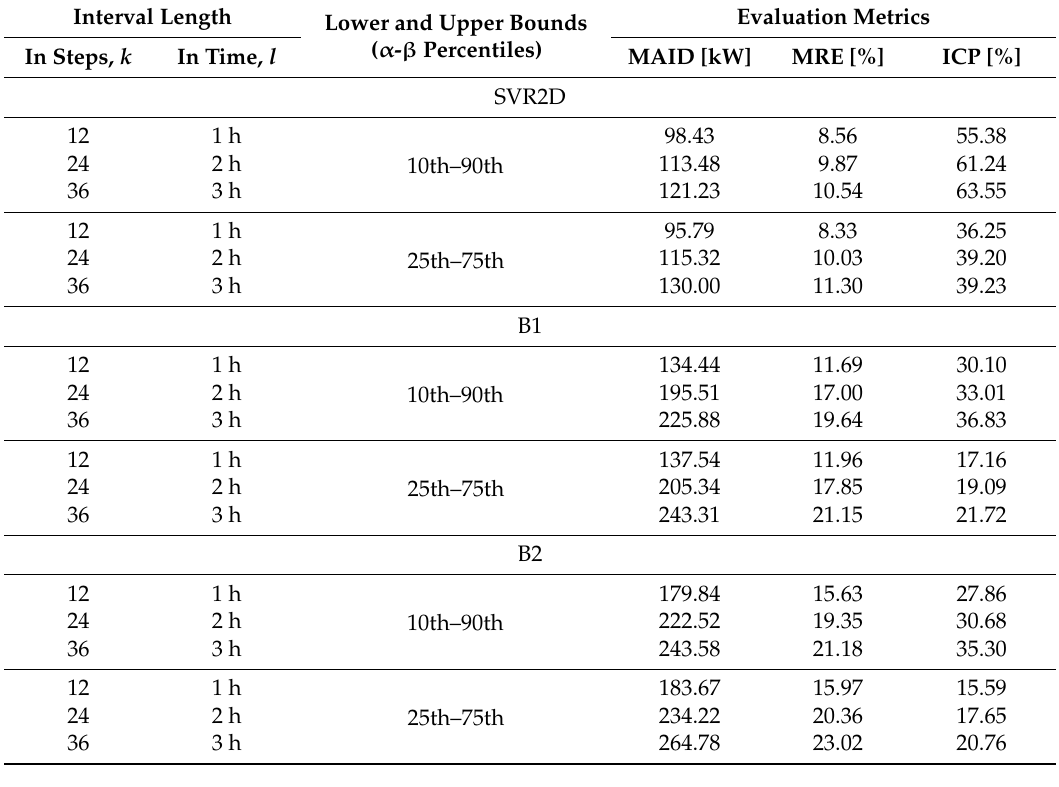
Table 5. Accuracy results for the methods used for comparison: SVR2D, B1 and B2.